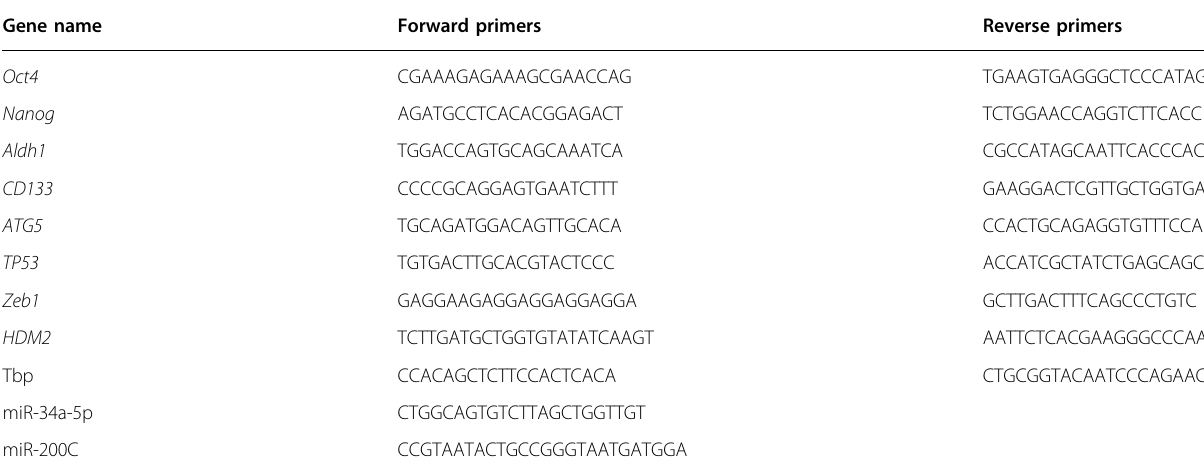
Table 1 PCR primer